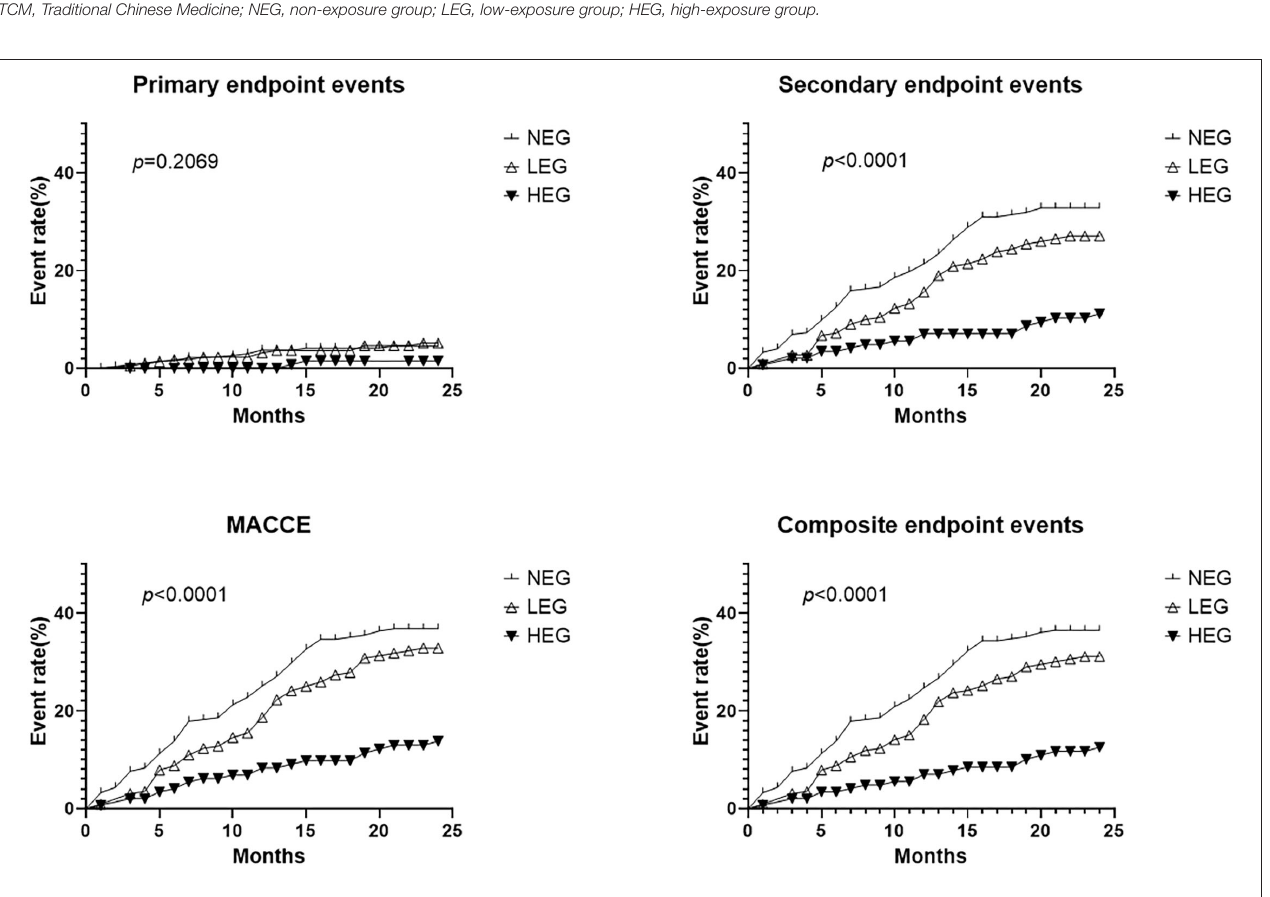
Frontiers in Cardiovascular Medicine |